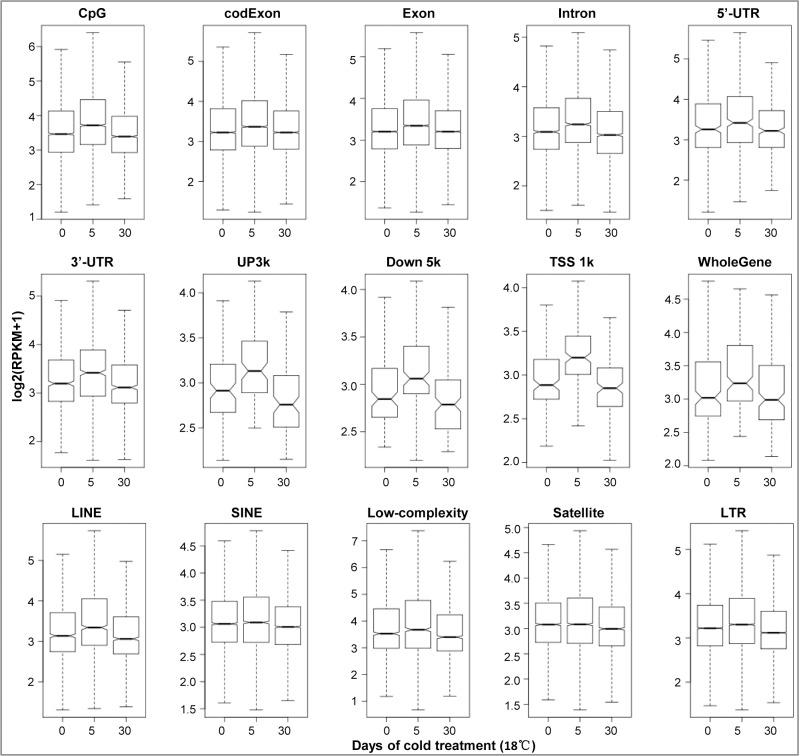
DNA methylation levels of different genomic regions under cold pressure.DNA methylation level of each genomic region from three samples (28°C, 18°C /5d, 18°C /30d) was shown as log2(RPKM+1). The RPKM value of each genomic region was compared as 18°C /5d vs 28°C, 18°C /30d vs 28°C and 18°C /30d vs 18°C /5d using T test. The corrected P values of FDR are shown in Table 1. CpG: CpG island; codexon: coding regions of exon; UP3k: regions within 3 kbs upstream gene; Down5k: regions within 5 kbs downstream gene; TSS 1k: regions within ±1 kb around transcription start site; LINE: long interspersed nuclear element; SINE: short interspersed nuclear element; Low complexity: low complexity DNA; Satellite: Satellite DNA; LTR: long terminal repeat.